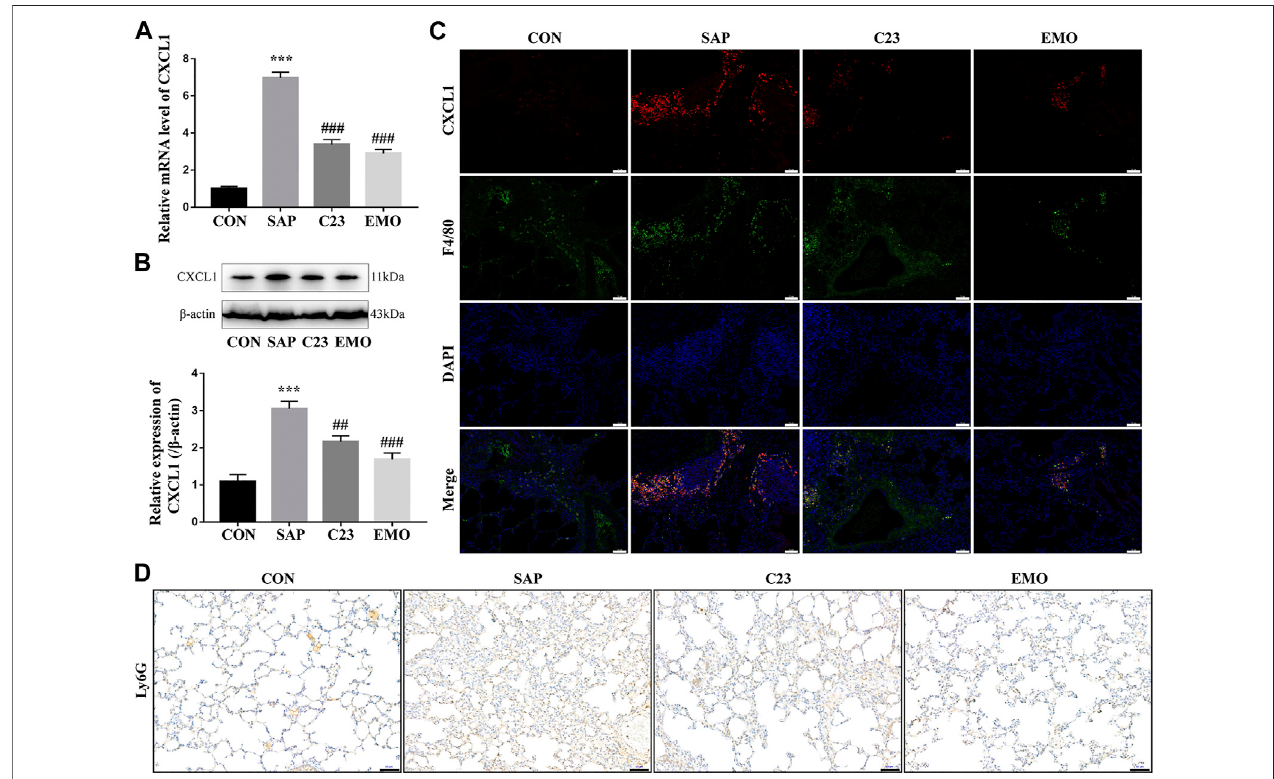
FIGURE 4 | Treatment with emodin or C23 reduces the SAP-enhanced CXCL1 expression and neutrophil in fi ltration in the lungs of rats. (A) Quantitative RT-PCR analysisoftherelativelevels ofCXCL1 tothecontrolGAPDHmRNAtranscriptsinthelungs ofrats. (B) Western blotanalysisoftherelative levelsofCXCL1 tothecontrol β -actinexpressioninthelungsofrats. (C) Immuno fl uorescentanalysisofCXCL1expressioninlungresidentmacrophagesusinganti-CXCL1(red)andanti-F4/80(green) (200 × magni fi cation). (D) Immunohistochemistryanalysisofin fi ltratedneutrophilsinthelungtissuesofratsusinganti-Ly6Gantibodies.Thedataarerepresentative images (200 × magni fi cation) or expressed as mean ± SD of each group of rats ( n (cid:1) 10 per group) from at least three separate experiments; *** p < 0.001 vs. the CON. ## p < 0.01, ### p < 0.001 vs. the SAP. Scale bar (cid:1) 50 μ